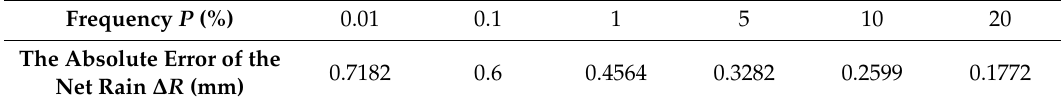
Table 3. Absolute error and corresponding frequency of the forecasted net rain.